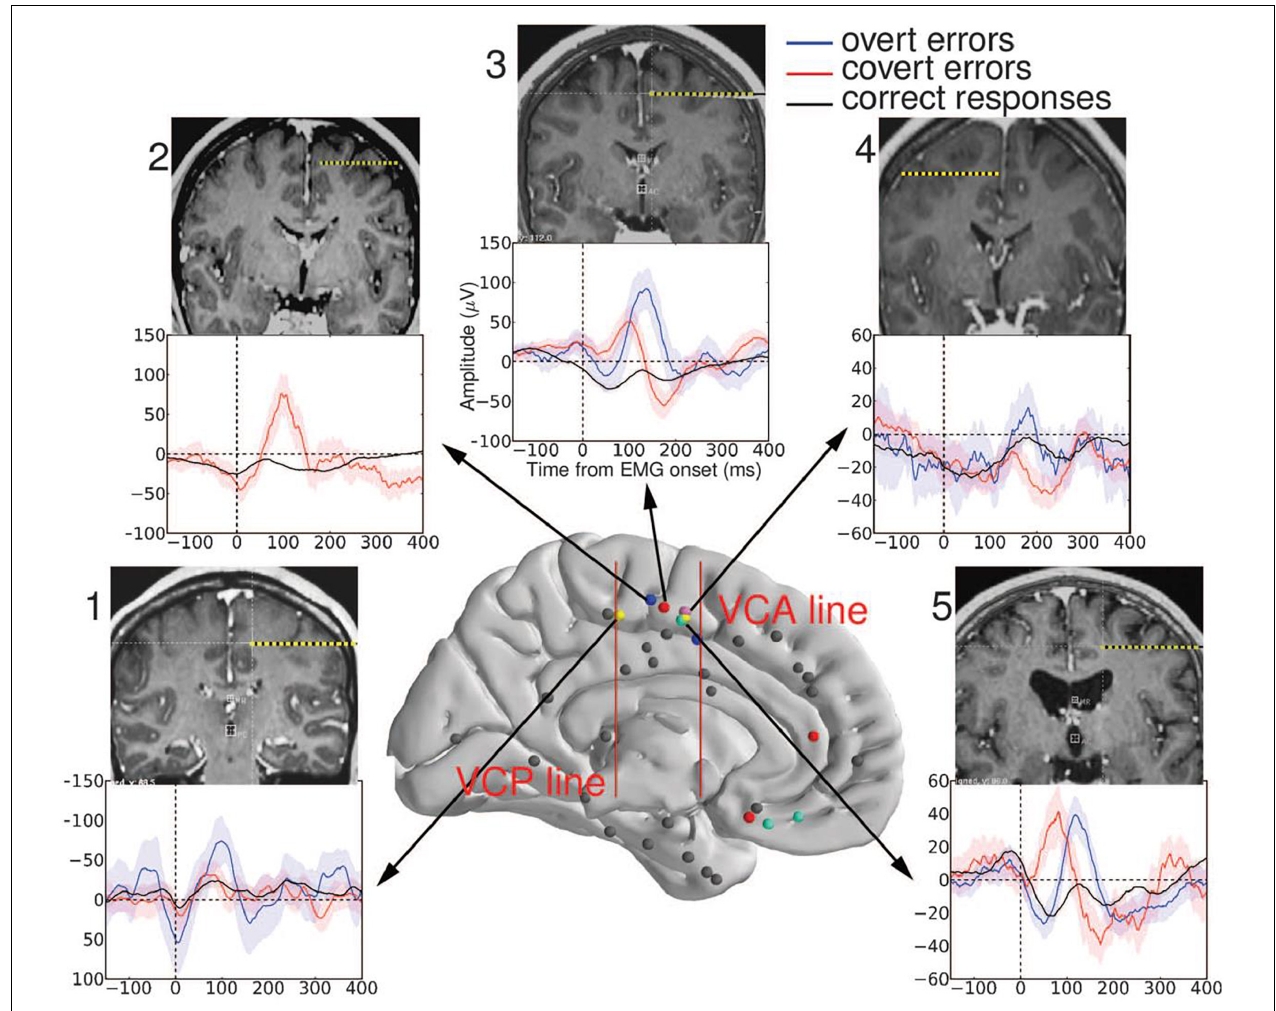
FIGURE 2 | Recording sites in the medial wall. The two red vertical bars represent the vertical commissure anterior (VCA) line and the vertical commissure posterior (VCP) line. A cluster of performance-sensitive sites (colored dots) is located behind the VCA line, in the supplementary motor area (SMA) (caudal cluster). Other performance-sensitive sites are more widespread in the rostral part of the medial prefrontal cortex (electrodes anterior to VCA) and respond later, on errors only. Averaged EMG-locked Local Field Potentials (LFPs) recorded from the SMA are displayed for each participant: The largest LFP is evoked after overt errors (blue); a smaller LFP is evoked after partial errors (red); and an even smaller LFP is evoked on correct responses (black). Colored bands represent between-trials confidence intervals set to 0.05. Individual MRI and CT fusion is also shown for each subject indicating, in coronal view, the trajectory of the performance-sensitive electrode. All these electrodes were clearly located above the calloso-marginal fissure and behind the VCA line (that is, in the SMA) reproduced with permission of the publisher (Science) (adapted from Bonini et al.,